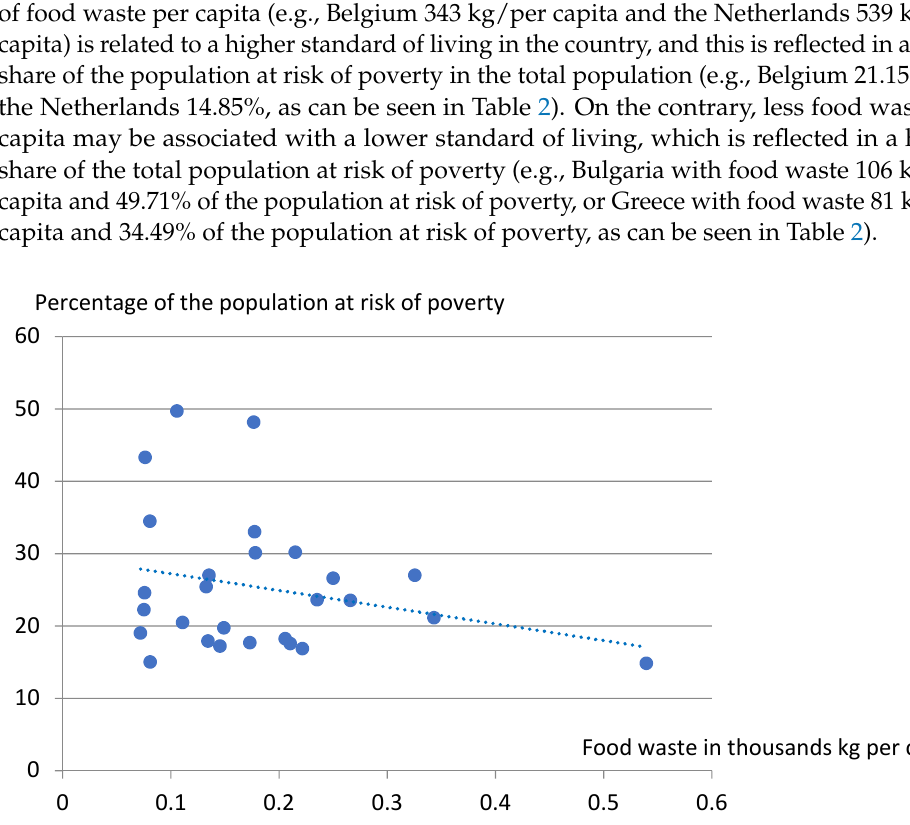
Figure 5. Relationship between the amount of food waste per capita and the percentage of the population at risk of poverty. Source: created by authors.